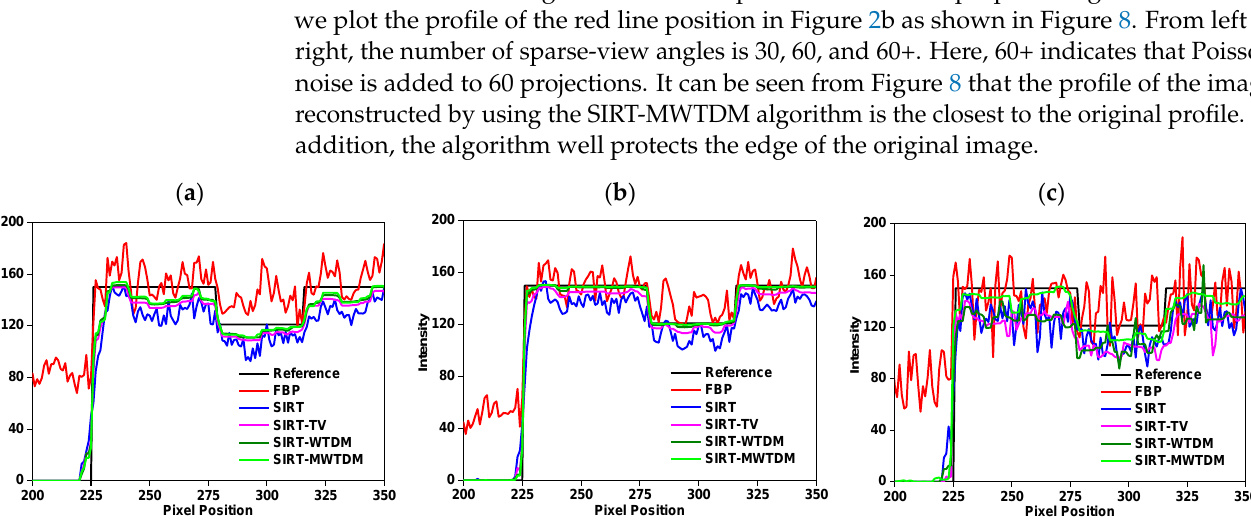
Figure 8. The profile of the red line position in Figure 2b. The number of projections is ( a ) 30; ( b ) 60; ( c ) 60+. Here, 60+ indicates that Poisson noise is added to 60 projections.